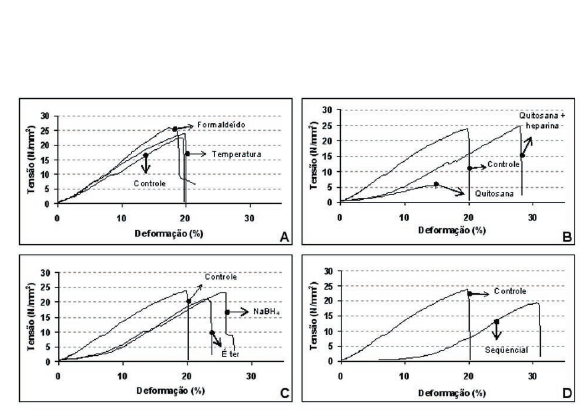
Fig. 3 - Curvas de tensão x deformação obtidas em função dos diversos tratamentos